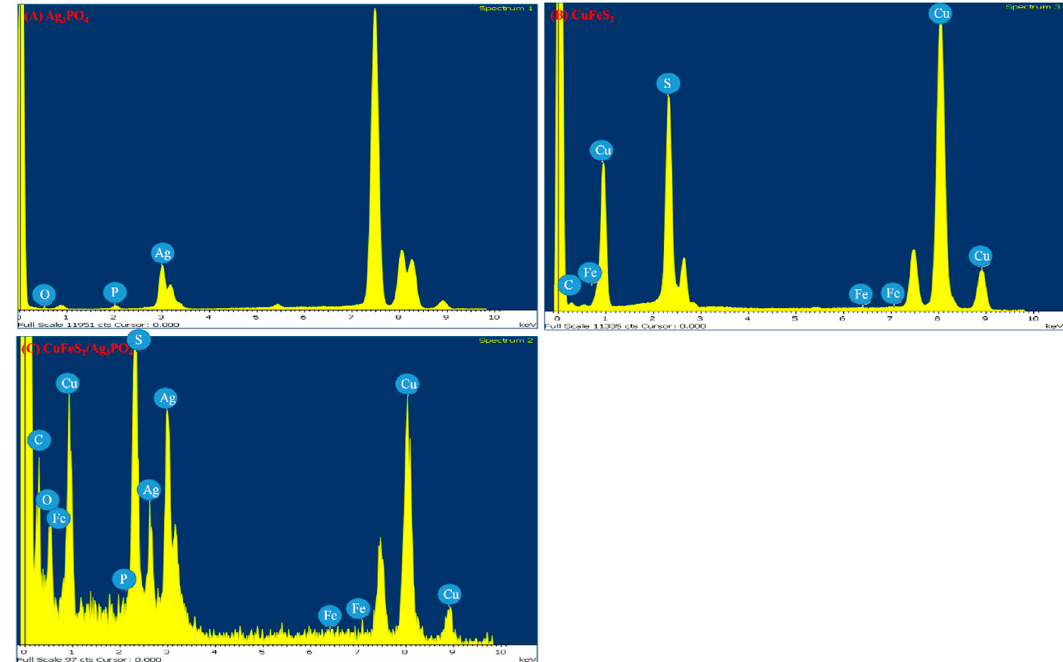
Figure 2. EDS spectra of ( A ) Ag 3 PO 4 ; ( B ) CuFeS 2 ; and ( C ) CuFeS 2 /Ag 3 PO 4 composites.